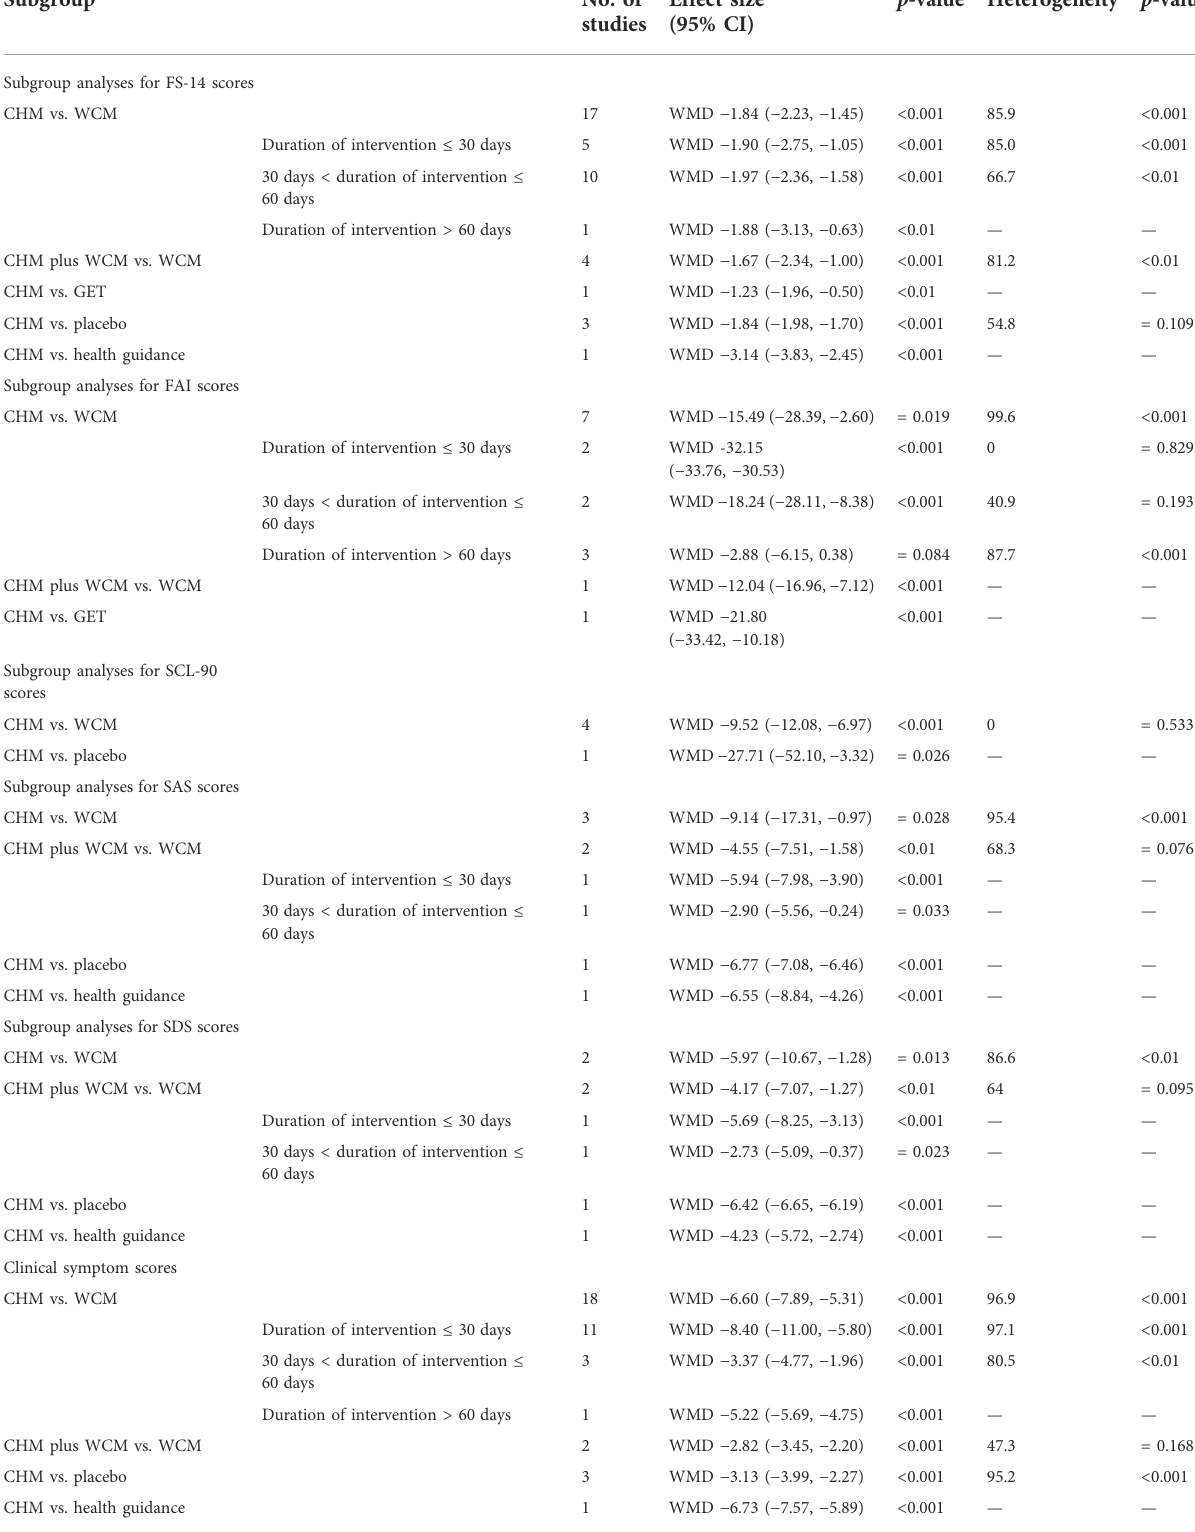
TABLE 4 Subgroup analysis for